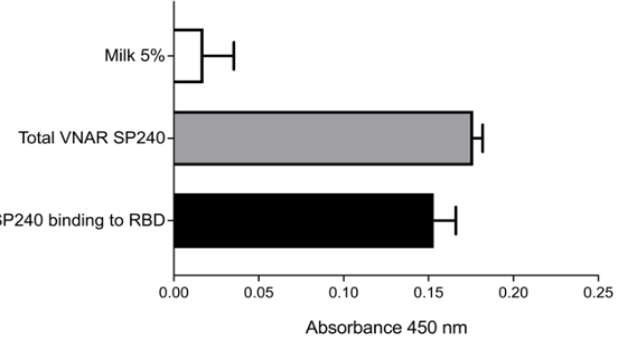
Figure 1. Assessment of VNAR SARS-CoV-2 binders as recombinant proteins and their recognition ability. The VNAR SARS-CoV-2 binders were obtained as soluble proteins at a small scale and their binding ability to the RBD from spike protein was evaluated by ELISA. Direct ELISA was performed to estimate the VNAR soluble protein (grey bars) obtained from an E. coli BL21 (DE3) expression system. The highest protein product was observed for VNAR SP327 and T1, and the lowest for VNAR SP240. However, the highest binding capacity to the RBD from the spike protein was shown by the VNAR SP240 in an indirect ELISA (black bars). We infer that other proteins might have contributed to the signal displayed for soluble proteins VNAR SP327 and T1. Indeed, the best relationship between expressed protein and target recognition was shown by VNAR SP240.